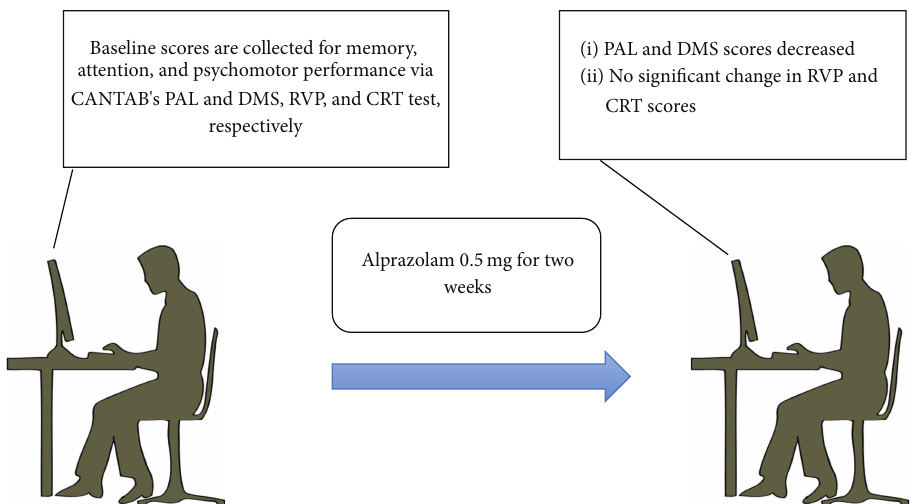
Figure 2: Effect of 0.5 mg alprazolam daily on healthy male volunteers for two weeks. Baseline data are collected for CANTAB’s PAL, DMS, RVP, and CRT tests. Then, subjects took 0.5 mg of alprazolam daily for two weeks. After two weeks, PAL and DMS score decreased compared to controls. RVP and CRT scores were